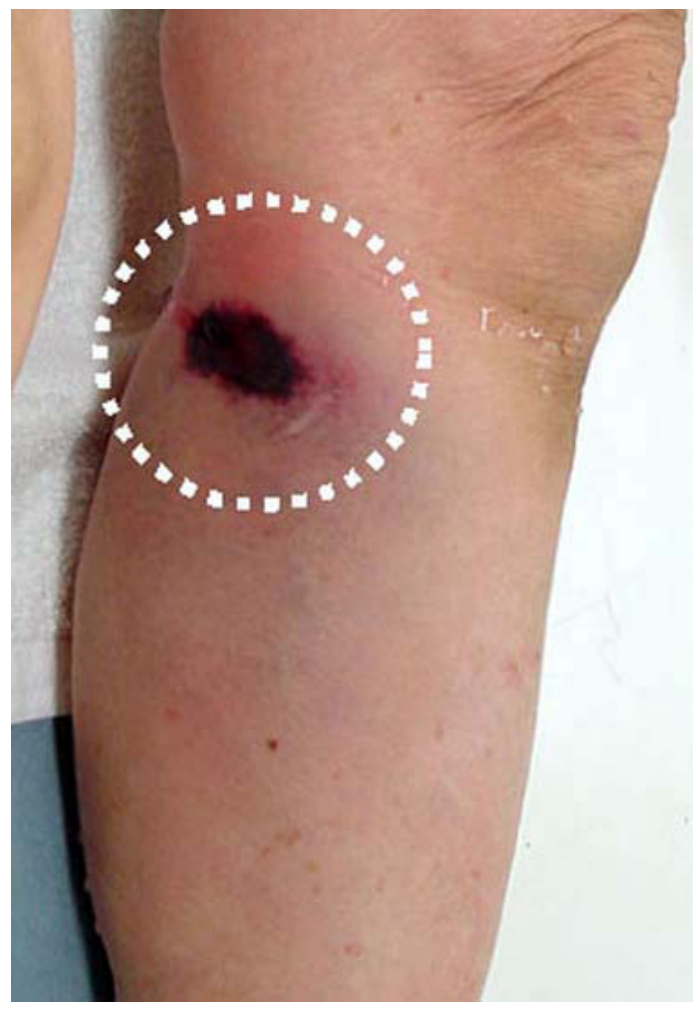
Figure 1. Initial examination showed that the left knee was swollen with an area of soft tissue necrosis measuring 3.5 x 2.0 cm around the fang mark. The dotted line indicates the debridement